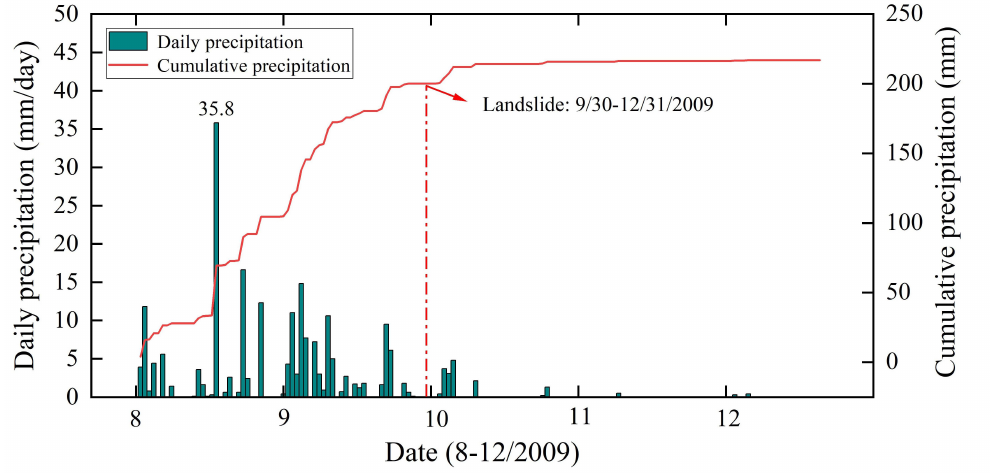
Figure 7. Daily and cumulative precipitation during August–December, 2019. A maximum daily precipitation of 35.8 mm was recorded in August